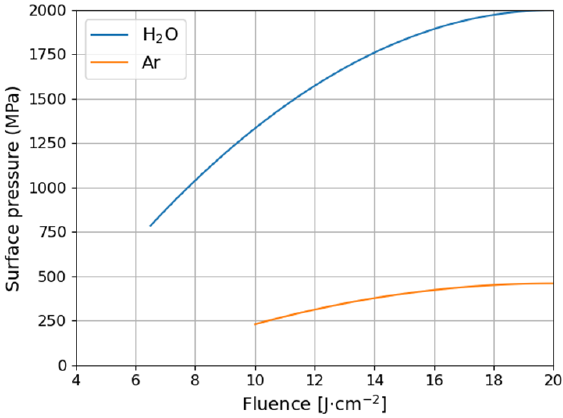
Figure 4. Maximum surface pressure as a function of laser fluence for water calculated in the model. Comparison for water and ambient gas Argon [48].